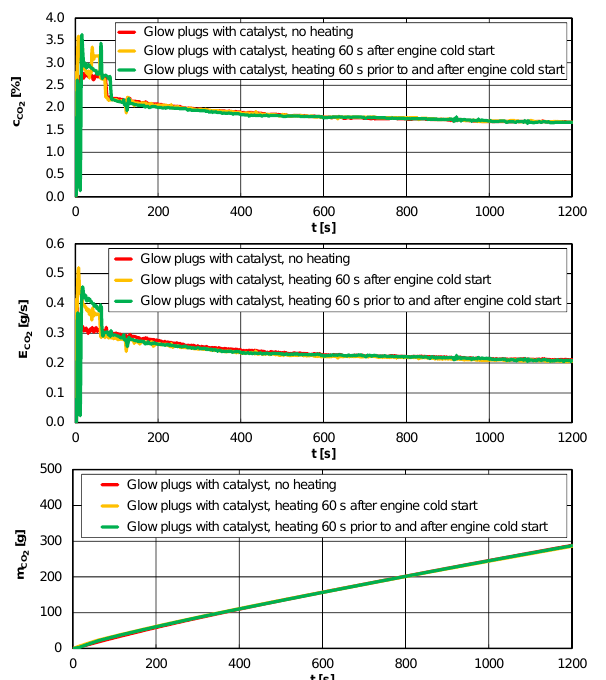
Fig. 6. Concentration, intensity of emission and emission of carbon diox- ide during the tests performed on a diesel engine depending on the cata-